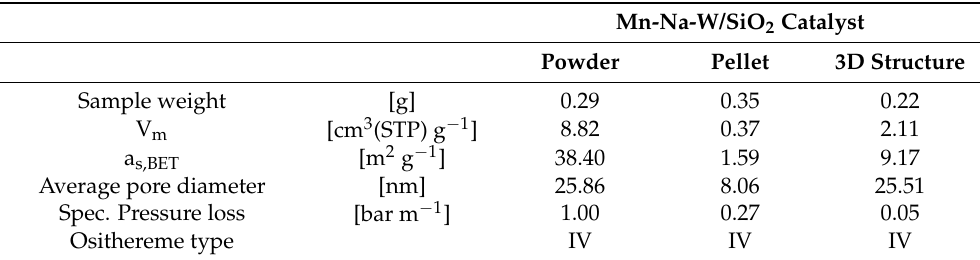
Table 1. Summary of the Brunauer–Emmett–Teller (BET) specific surface area results and pore sizing for pelletized powder and 3D printed